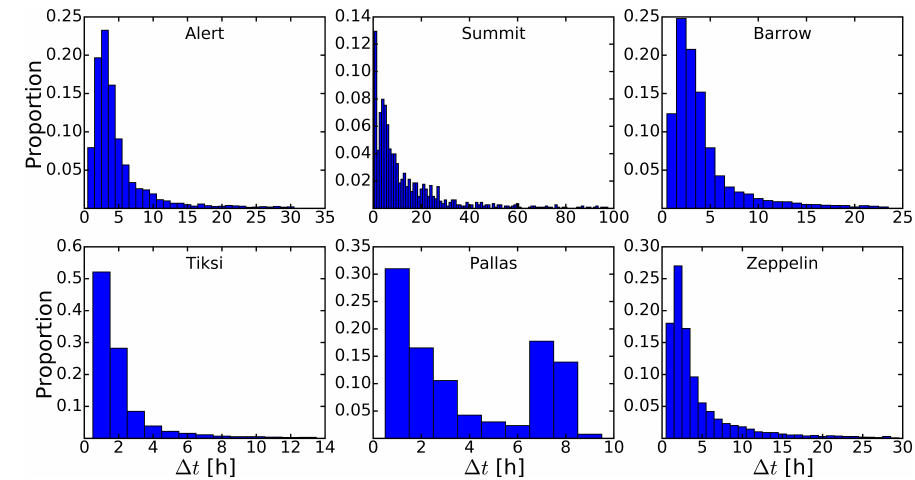
Figure 7. Normalized histogram of the collection time (cid:49)t for the different stations for a (cid:49) ATN threshold of